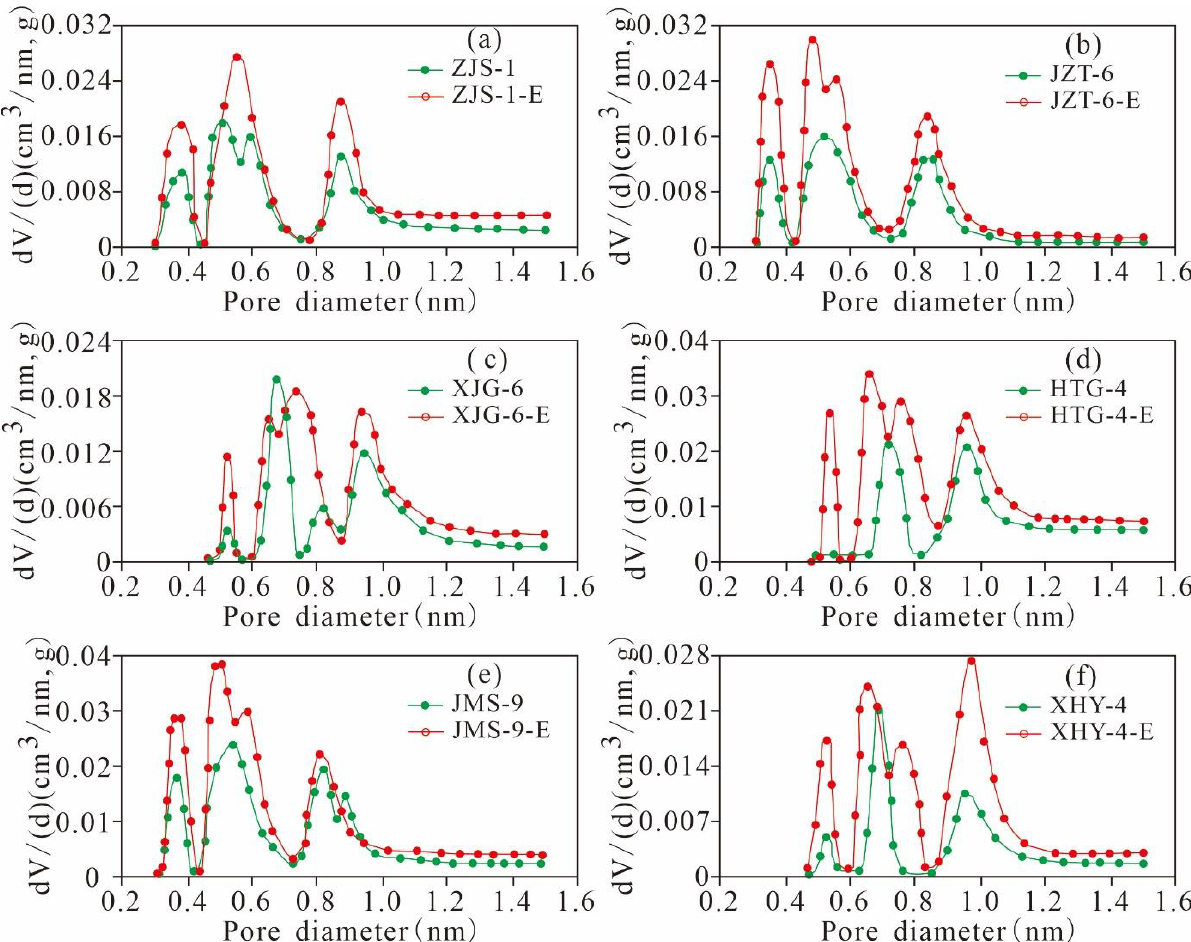
Figure 19. Micro-PV of the original shale and its corresponding extracted sample varies with pore size (( a ), ZJS-3; ( b ), JZT-6; ( c ), XJG-6; ( d ), HTG-4; ( e ), JMS-9; ( f ), XHY-4).